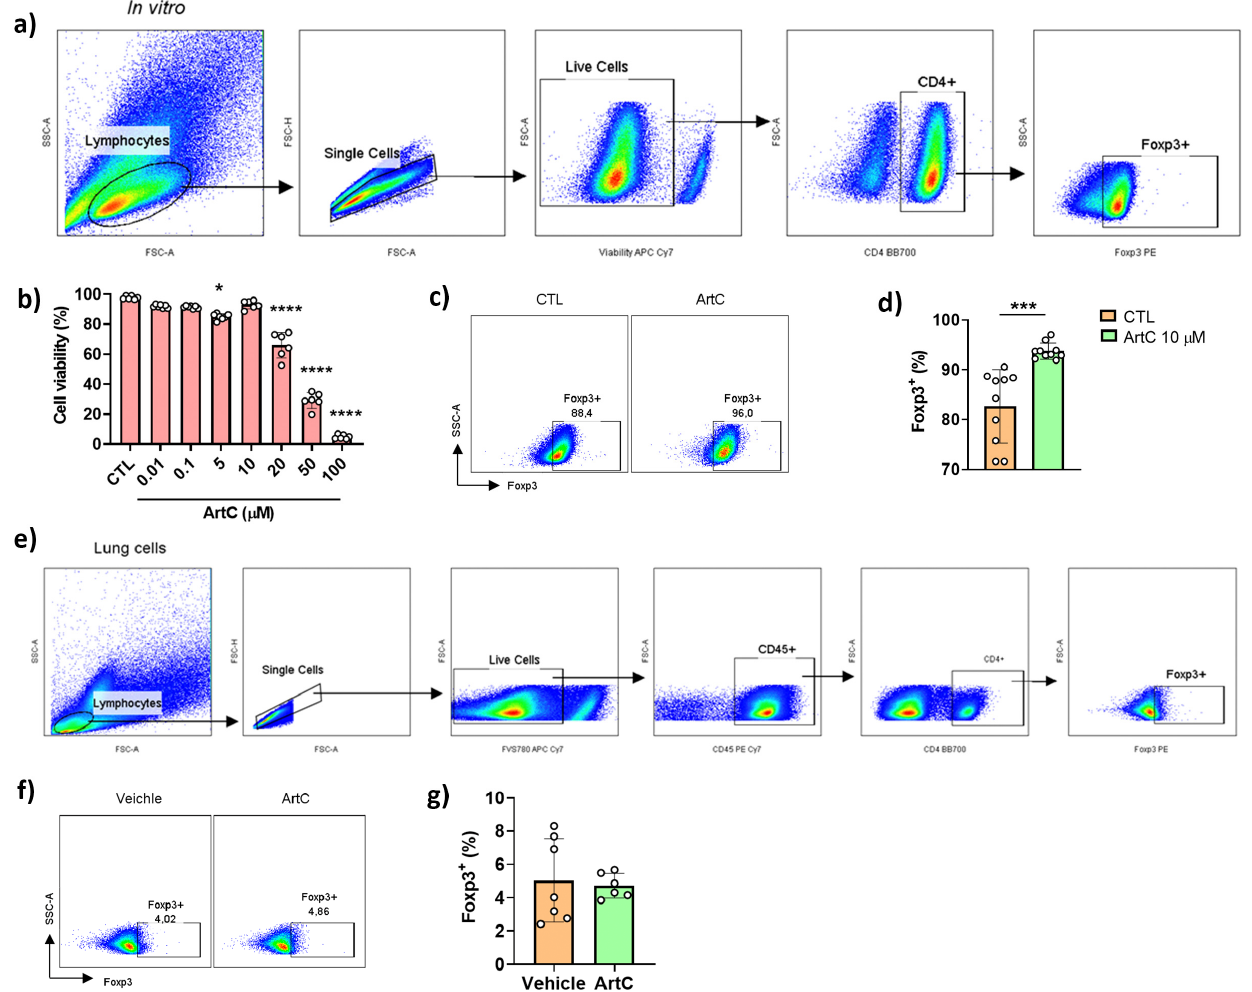
Figure 3. ArtC induces Treg cells differentiation in vitro. ( a ) Gate strategy for Treg cell (CD4 + Foxp3 + ) characterization in vitro by flow cytometry; ( b ) frequency of live cells (FVS780 − ) in culture of CD4 + T cells stimulated with ArtC versus control (CTL); ( c ) representative dot plot of Treg cells generated in vitro in the presence or absence of ArtC; ( d ) percentage of Treg cells generated in vitro. Data are representative of three independent experiments (n = 3–4/group/experiment) and expressed by mean ± SD; ( e ) gating strategy for Treg cell characterization in vivo; ( f ) representative dot plot of Treg cell in the lungs of mice exposed to the allergen and treated or not (vehicle) with ArtC; ( g ) frequency of Treg cells in the lungs. Data are representative of two independent experiments (n = 4–5/group/experiment) and expressed by mean ± SD. * p < 0.05, *** p < 0.001 and **** p < 0.0001.